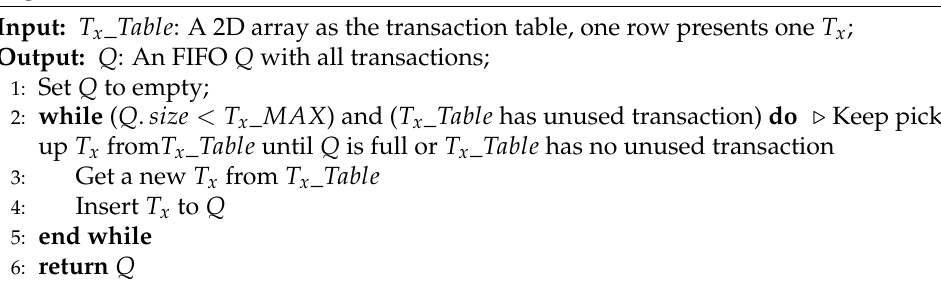
Algorithm 3 Transactions selected with the FIFO